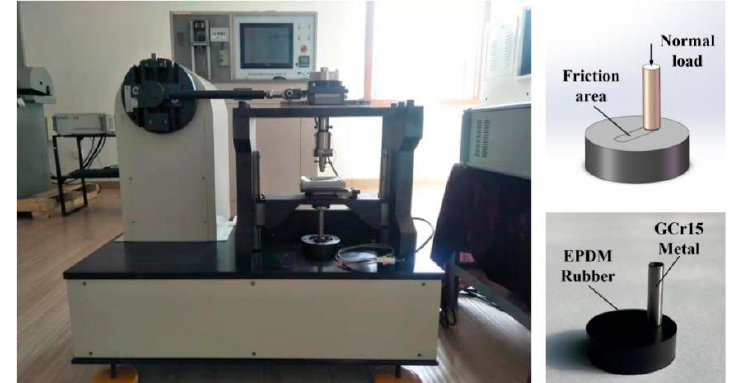
Figure 4. UMT-2 reciprocating test device.